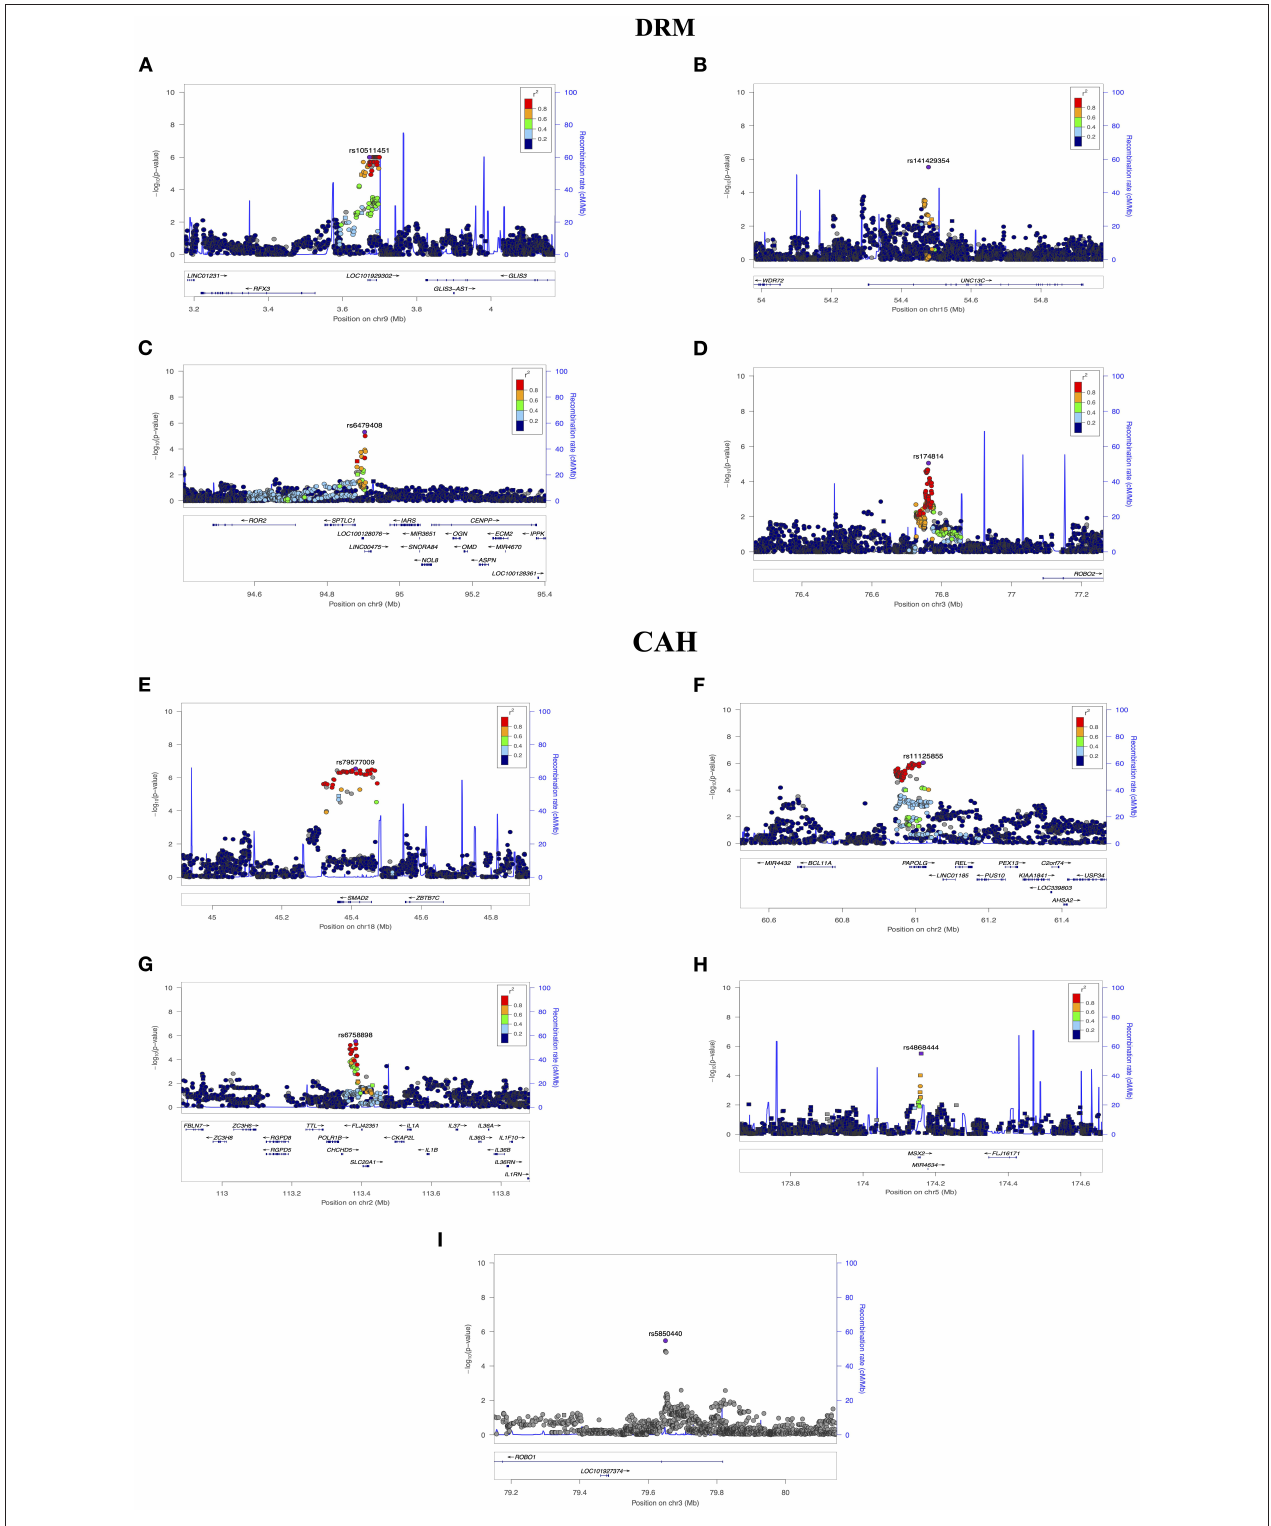
FIGURE 4 | Regional Association Plots from (DRM) and (CAH) results. LocusZoom were used to generate plots for regions of Interest. (A) Suggestive locus near GLIS3 on chromosome 9. (B) Suggestive locus near WDR72 gene on chromosome 15. (C) Suggestive locus near ROR2 and OMD on chromosome 9. (D)